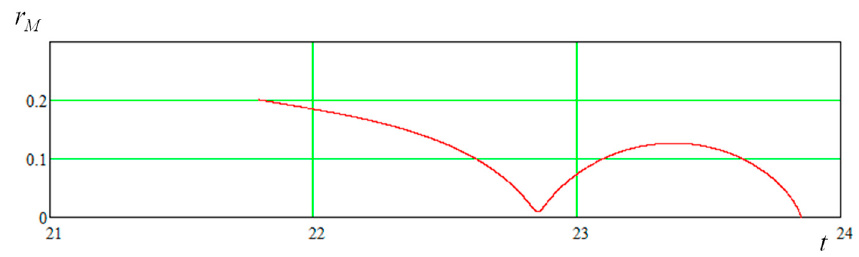
Figure 28. Selenocentric r M [undim.] distance along the optimal flight trajectory.